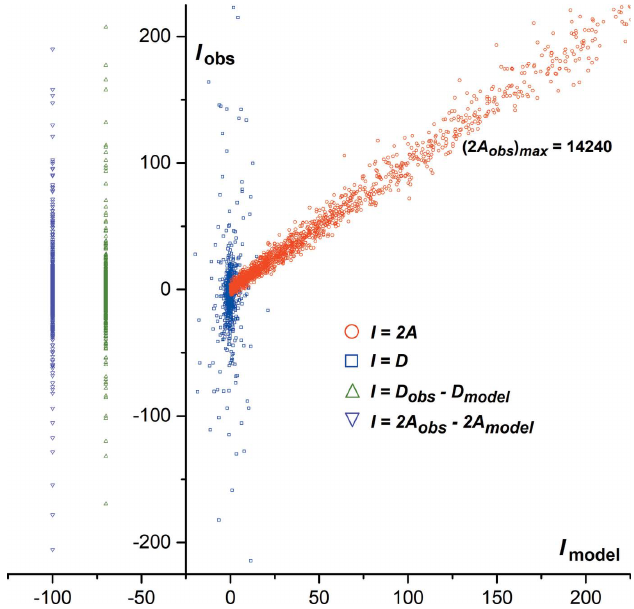
Figure 2 2 AD plot for 1941 acentric Friedel pairs retrieved from the SHELXL fcf file for the last refinement cycle of the title compound (Sheldrick, 2015 b ). The D obs against D model of all Friedel pairs (blue squares) and the 2 A obs against 2 A model for weak Friedel pairs (red circles) are displayed. On the left, D obs (cid:3) D model (green triangles) and 2 A obs (cid:3) 2 A model (violet triangles) of all Friedel pairs are displayed, at arbitrary fixed abscissa. The style of the 2 AD plot follows that used in the articles of Flack et al. (see, for example, Fig. 3 in Parsons et al. , 2012).